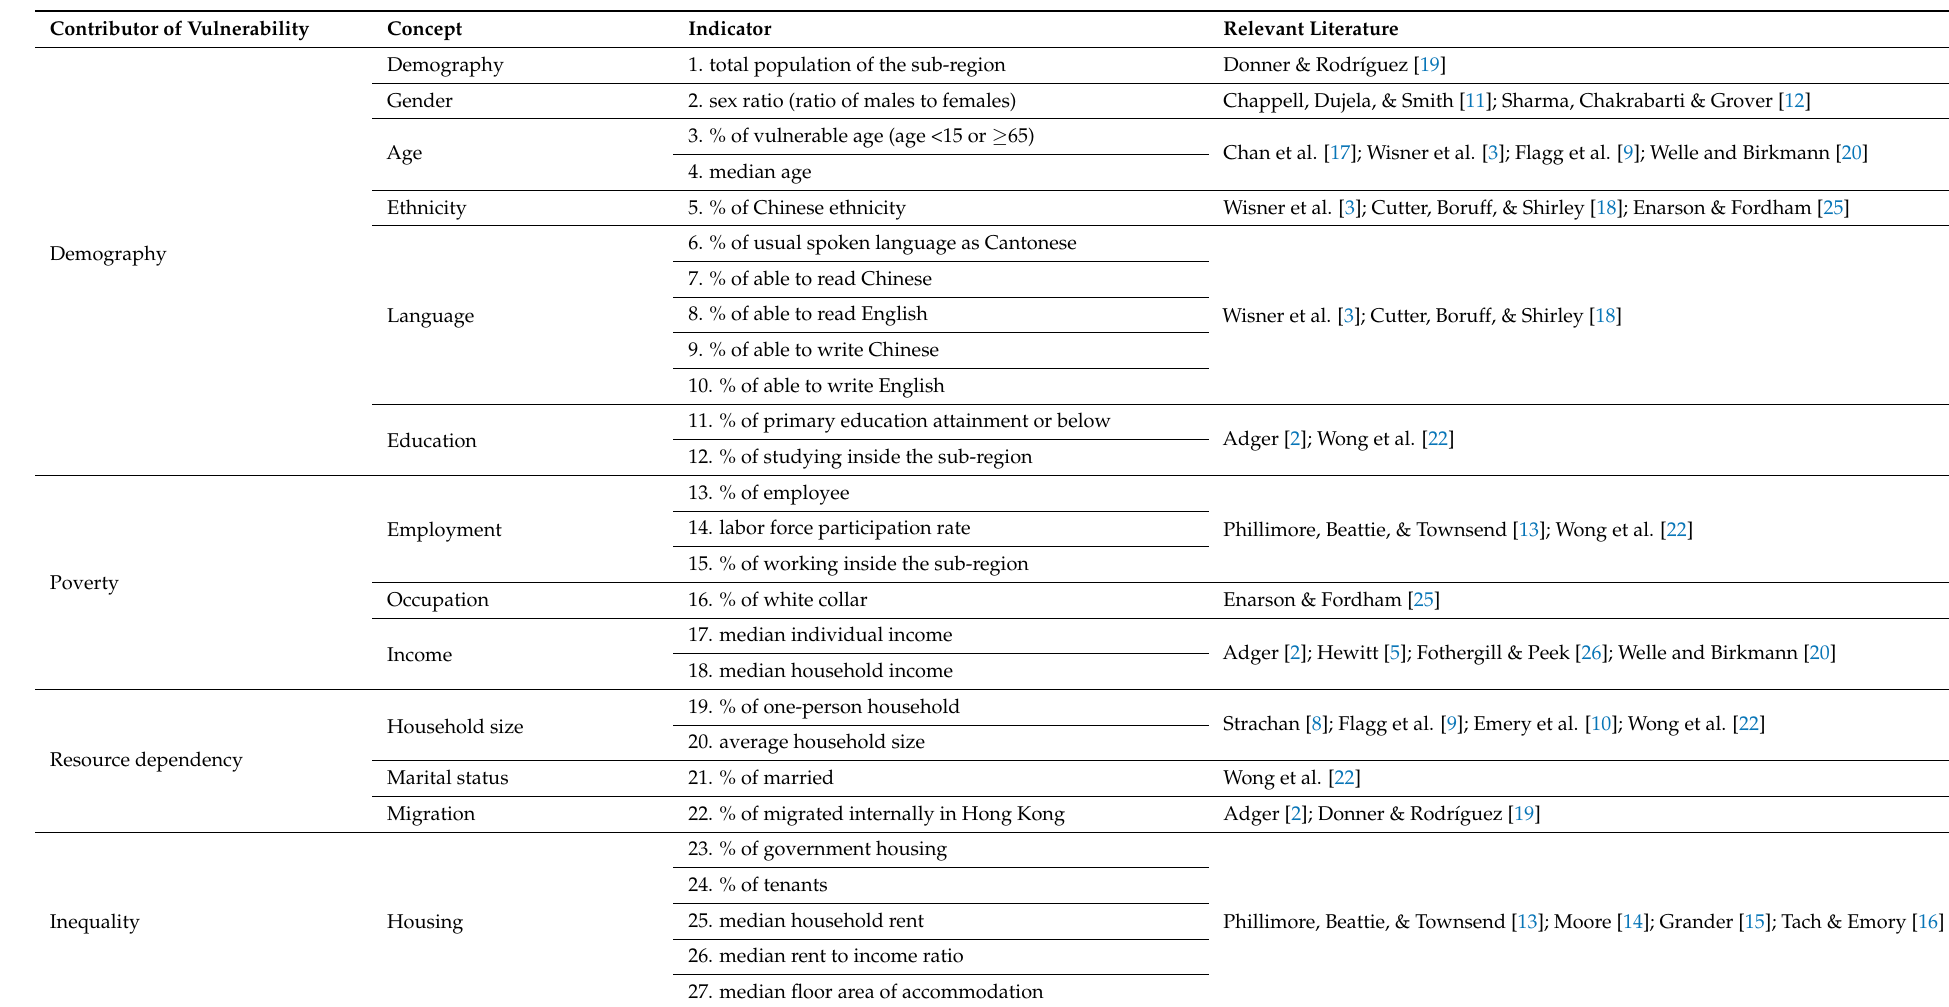
Table 1. Key indicators of socioeconomic